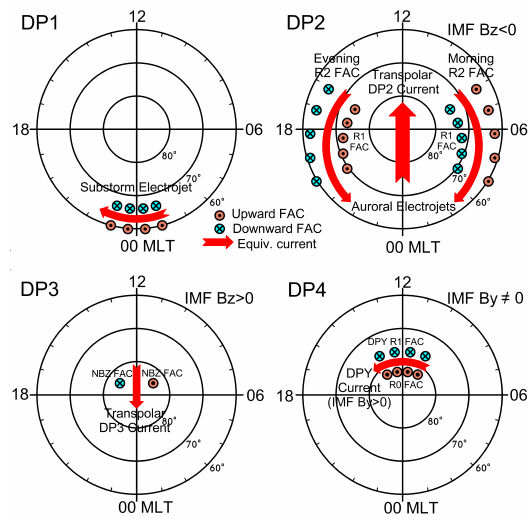
Figure 1. Sketches of ionospheric and field-aligned currents related to DP1 (substorm), DP2 (forward), DP3 (reverse), and DP4 (DPY) polar convection